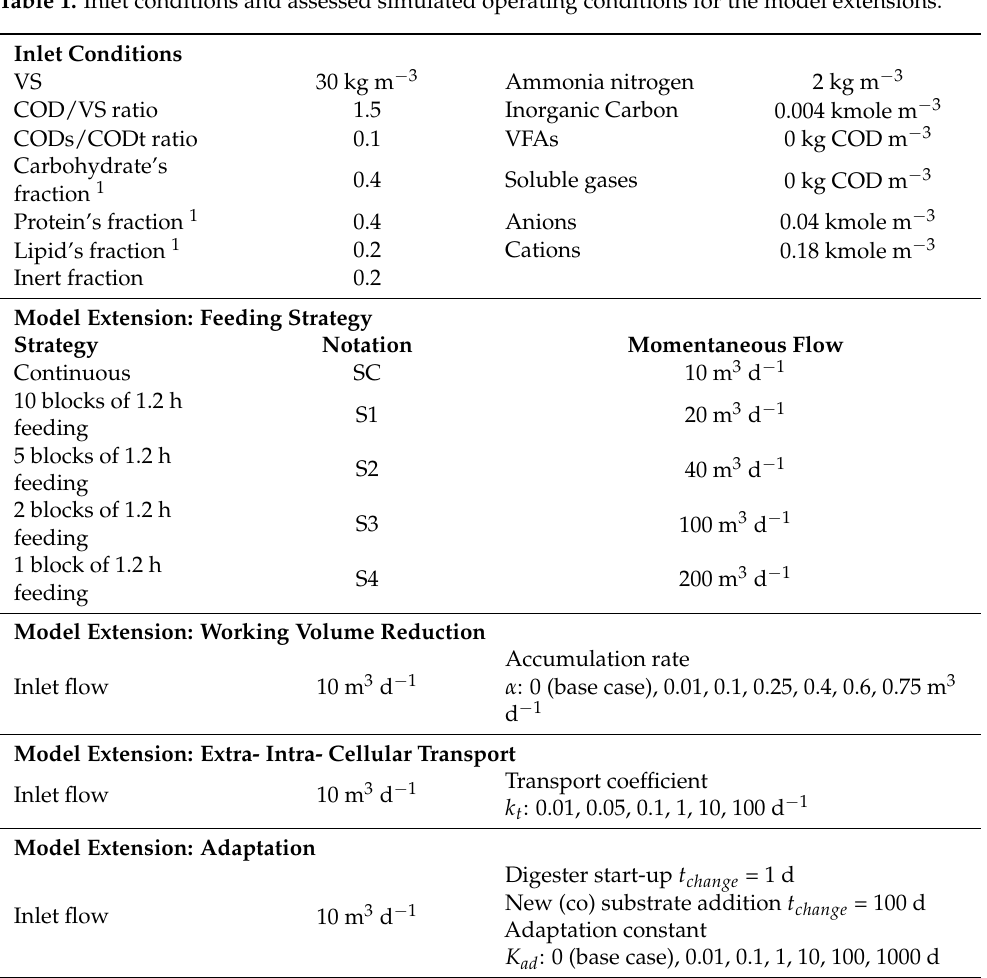
Table 1. Inlet conditions and assessed simulated operating conditions for the model